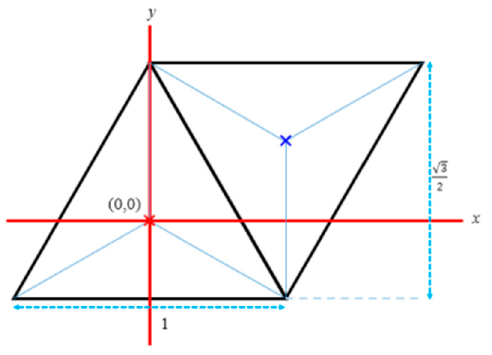
Figure 3. Side-length and height of triangle pixels at the triangular grid. The midpoints of the pixels are also marked. The even midpoint shown is the origin of the grid.